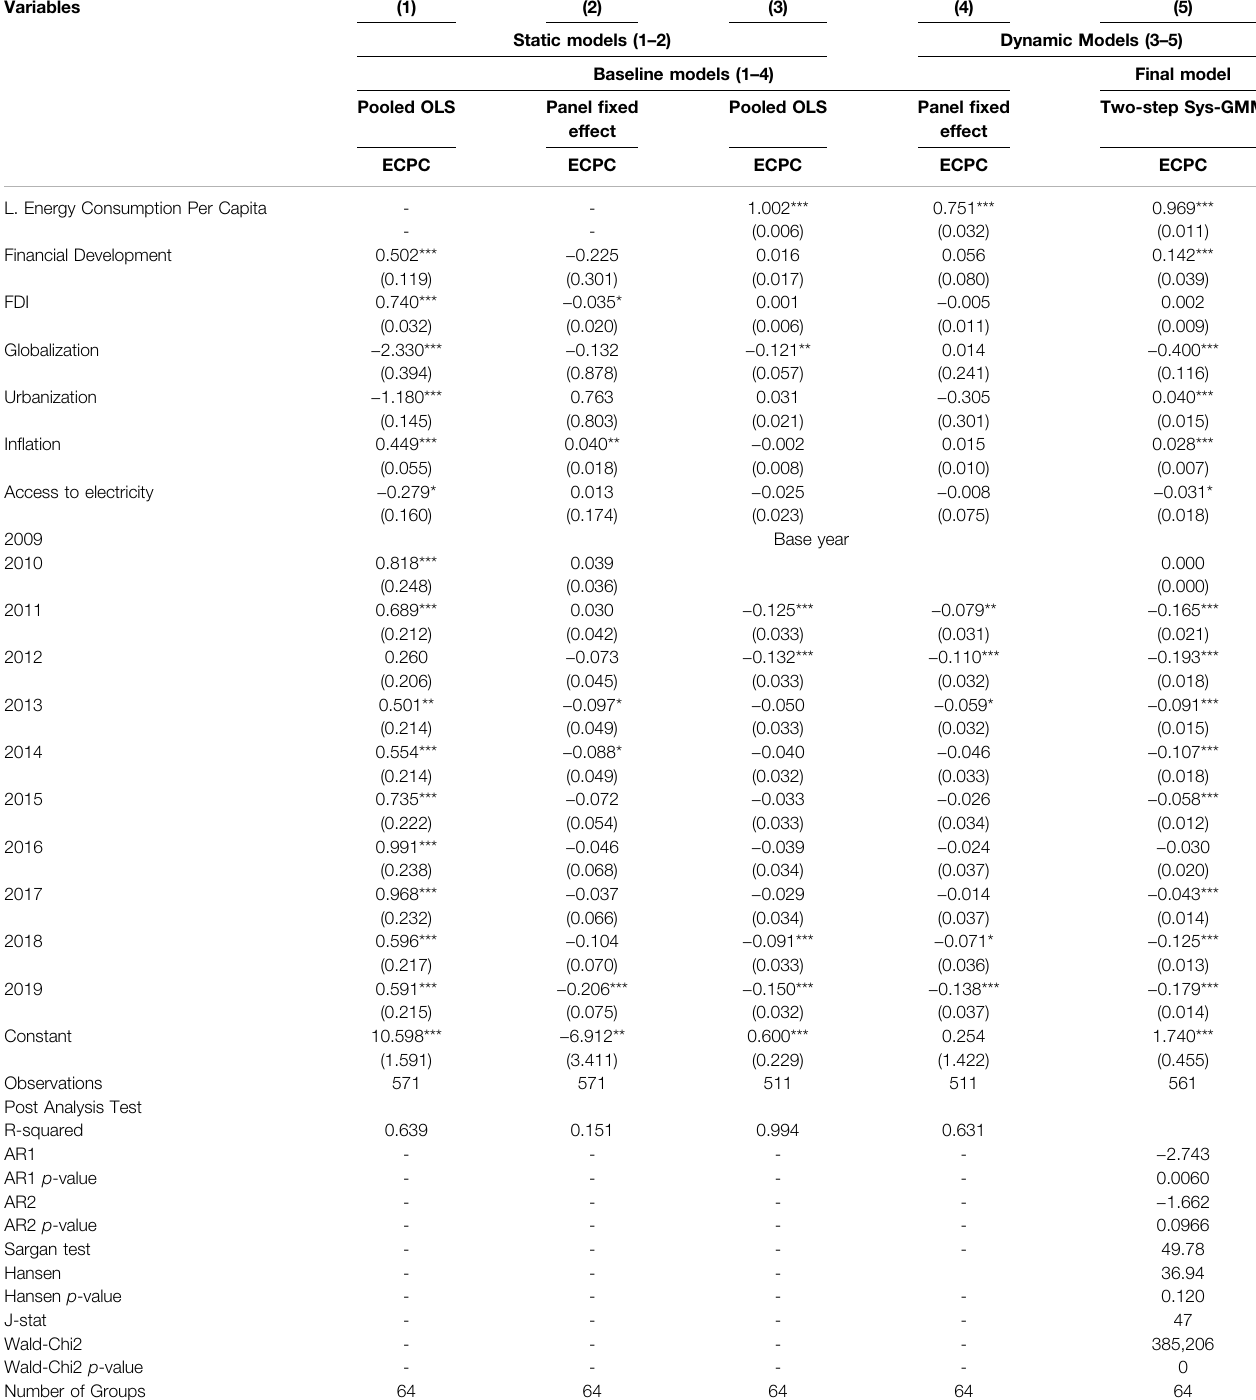
TABLE 7 | Results of FD, FDI, Globalization and Urbanization impact on Energy Consumption.